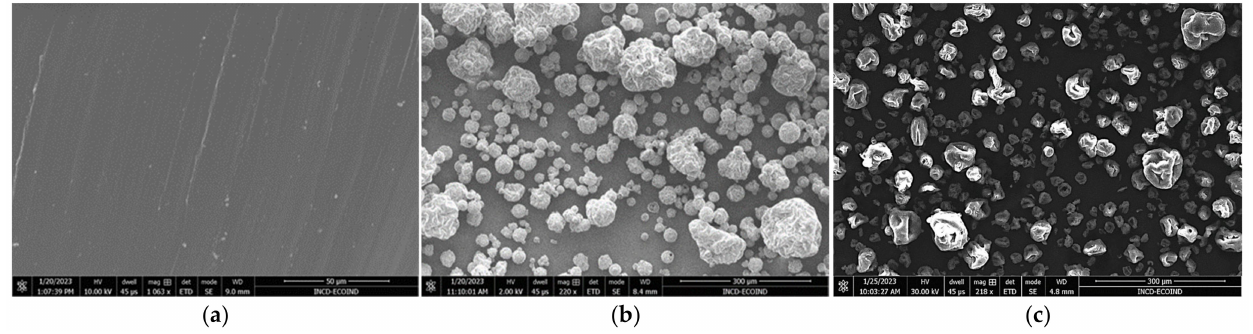
Figure 3. SEM images of ( a ) base polymer matrix; ( b ) Chlorella vulgaris biomass powder, and ( c ) Spirulina platensis biomass powder.